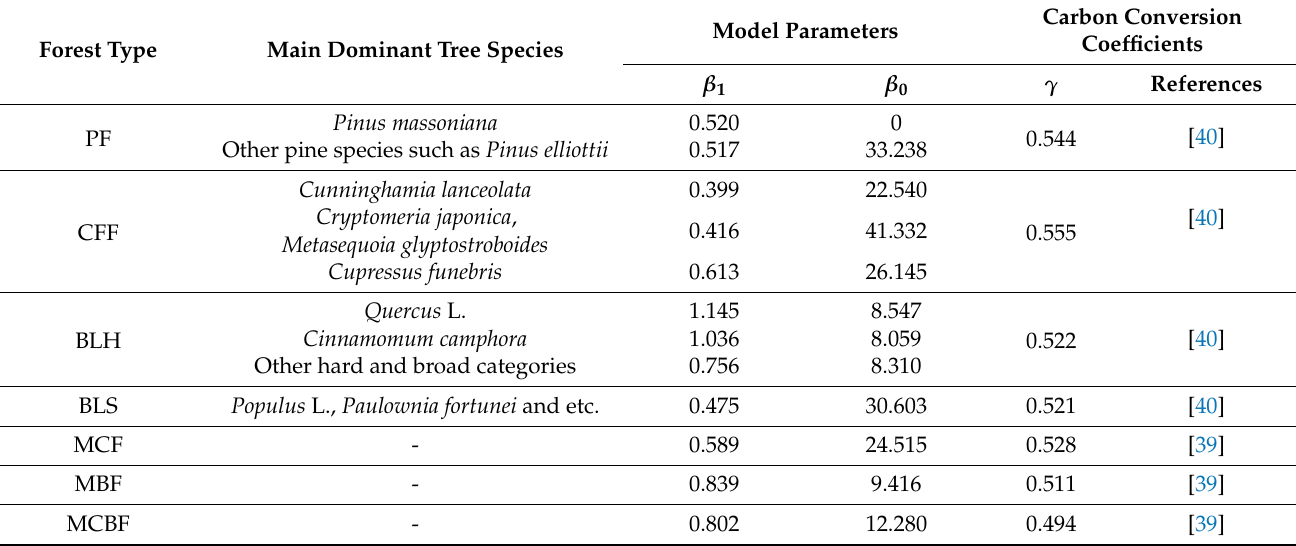
Table 1. BEF parameters and carbon content coefficients of forest types.